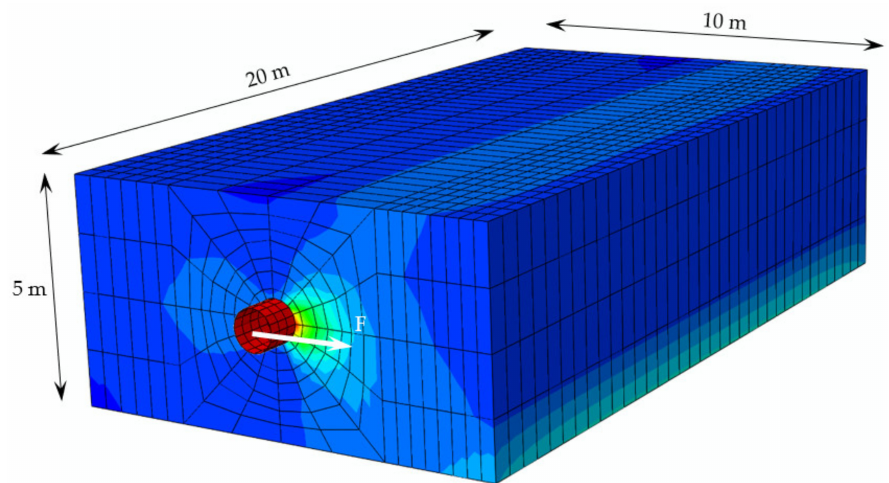
Figure 7. 3D solid model for the lateral sliding test of a buried pipeline (displacement